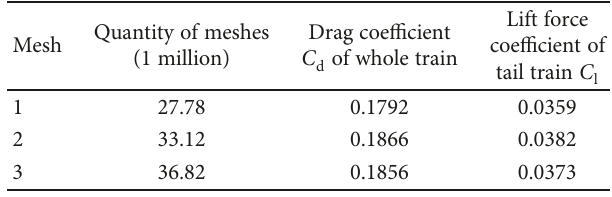
Table 1: Computation results of three sets of meshes.